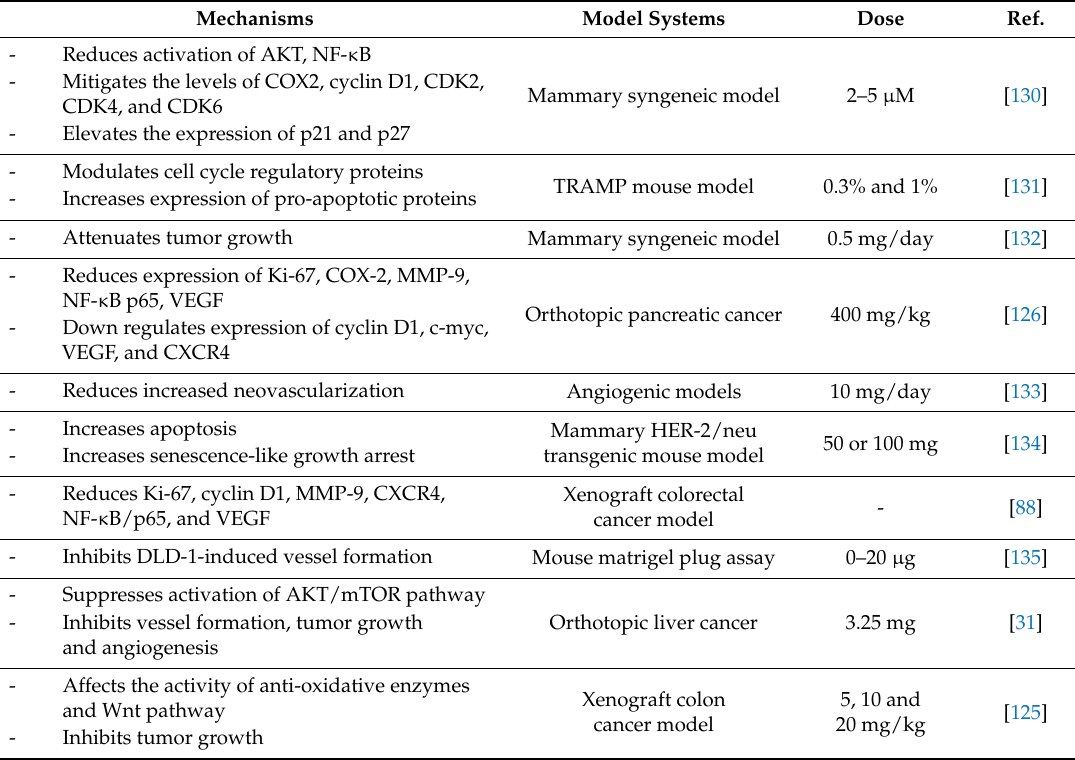
Table 2. A brief overview of in-vivo studies carried out using